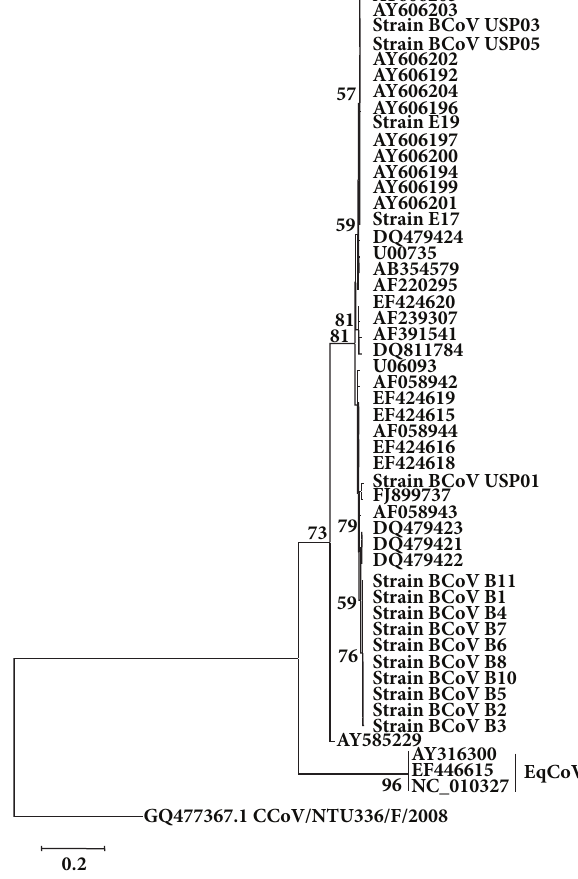
Figure 3: Phylogenetic tree for partial sequences of S gene (nt. 1395 to 1667 of Mebus strain GenBank accession number